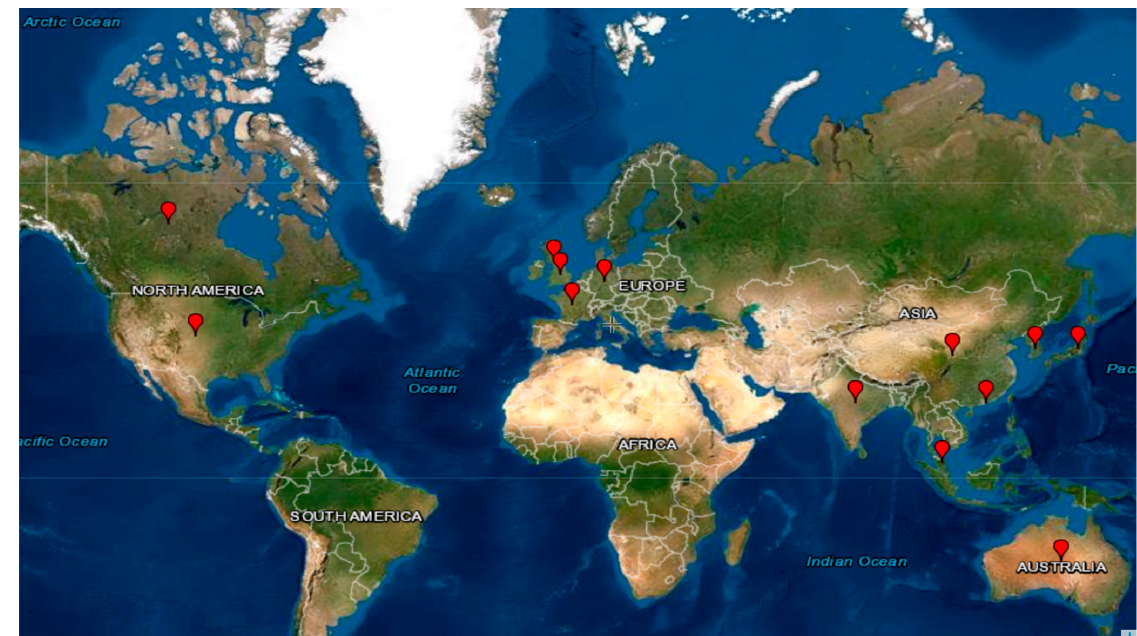
Figure 17. GPS visualization of countries contributing to EV BMS state estimation.